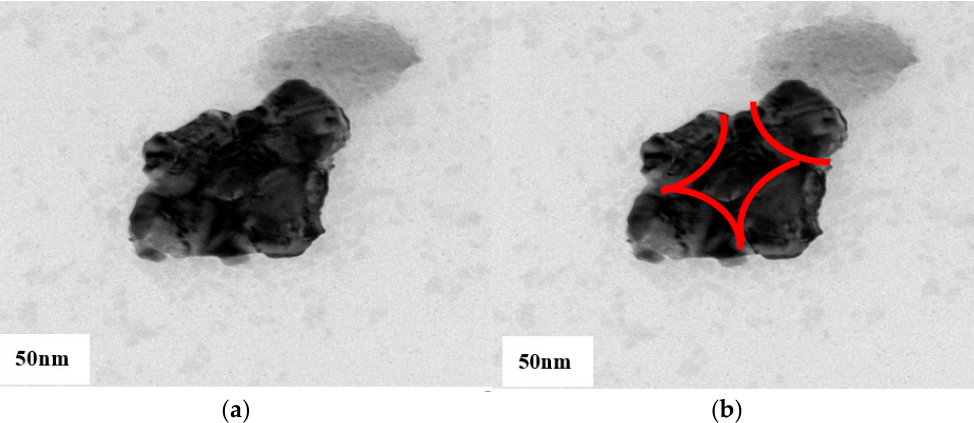
Figure 6. ( a ) Transmission electron microscopy (TEM) analysis of GNPs observed a defect in Sample D. ( b ) TEM analysis of GNPs observed many GNPs were combined with large GNPs by the chain polymerization reaction.